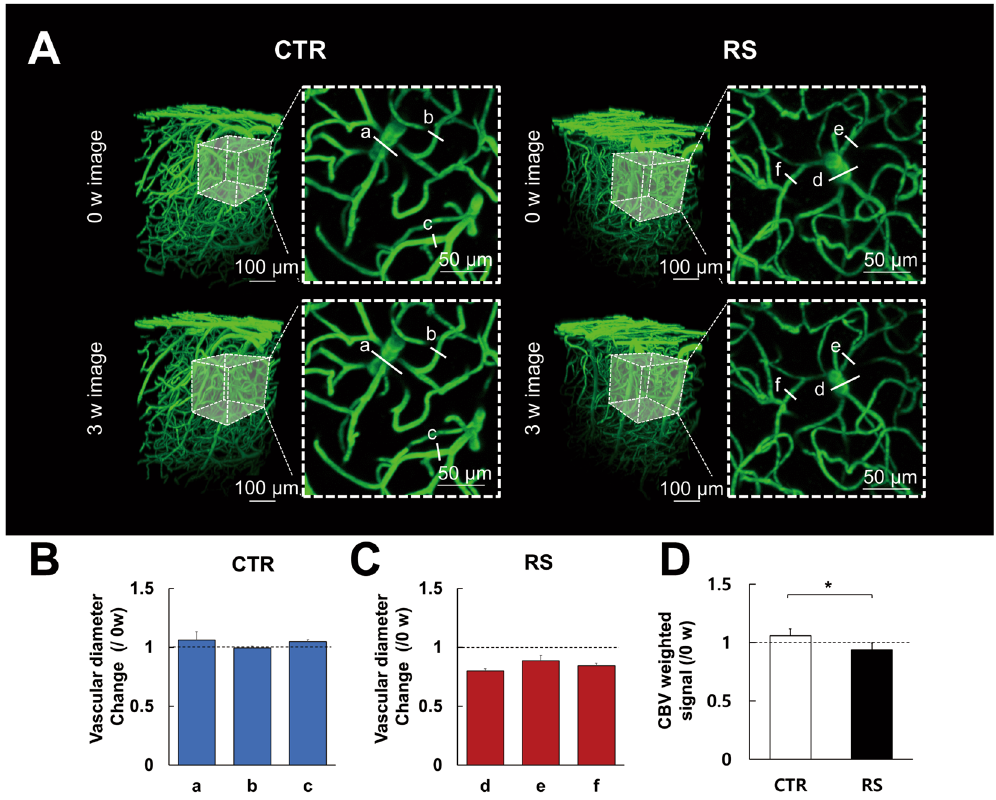
Figure 2. Cerebro-vascular structure following chronic restraint stress. ( A ) Representative images were longitudinally acquired in the control and RS groups. Two-dimensional images (dashed square) are the maximum intensity projection of 3D images with a 100 μ m thickness (dashed cube). a-f indicate vessel diameter. Vascular diameter changes of representative images in the CTR ( B ) and RS ( C). ( D ) Cerebral blood volume (CBV) weighted intensity signal at 3 w shown as the ratio to 0 w. CTR, control group; RS, restraint stress group; * p <